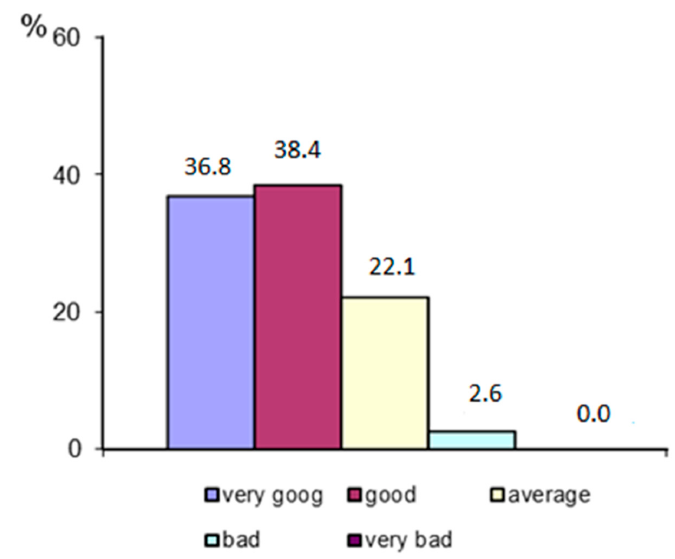
Figure 2. The respondents’ self-assessment of health status.